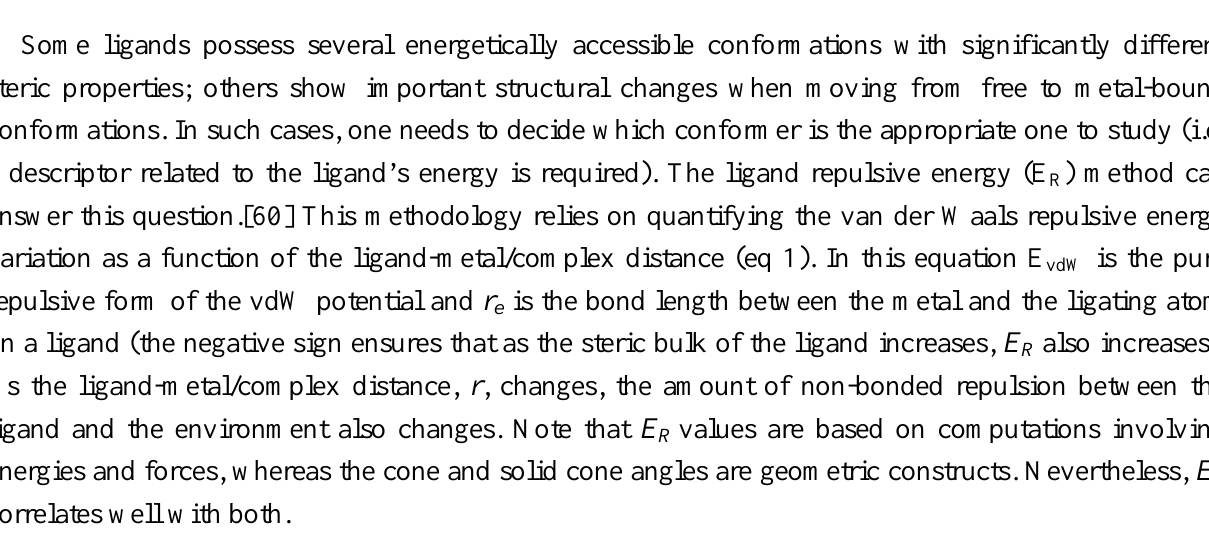
)(NO)] + as viewed down the olefin 3